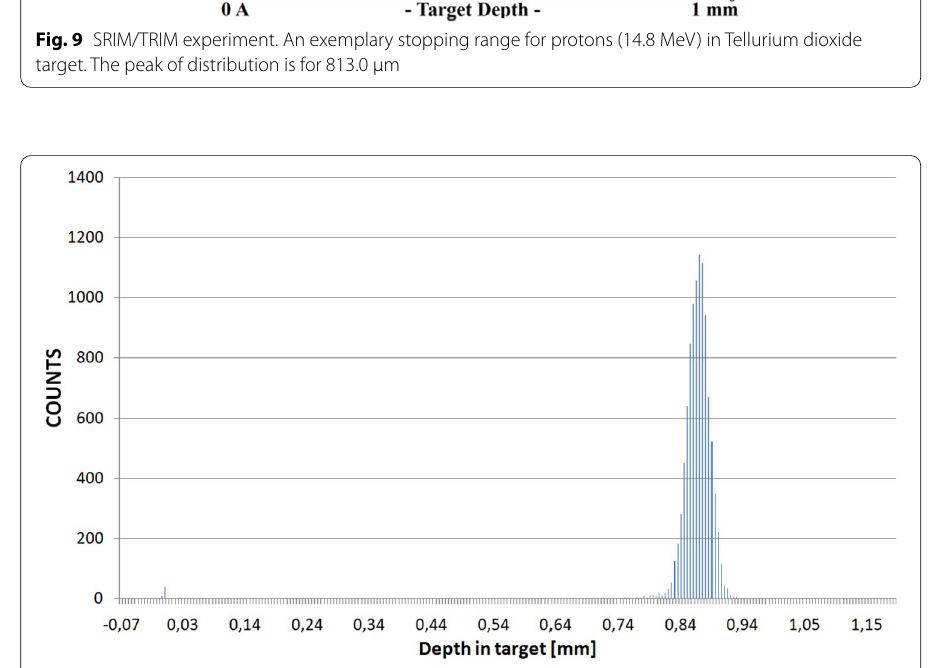
The peak of distribution is for 886.2